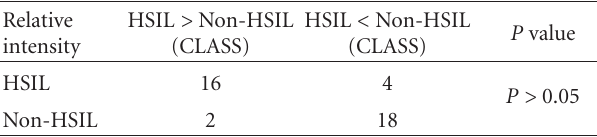
Table 1: CLASS data compared to cytology